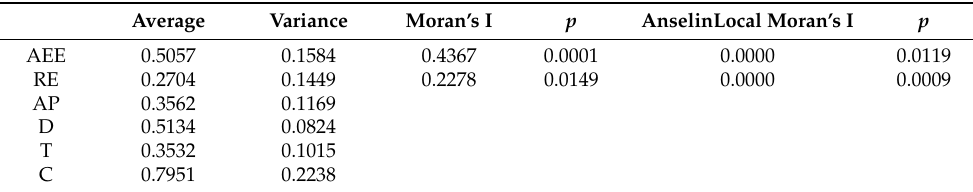
Table 5. Descriptive statistics of comprehensive evaluation in